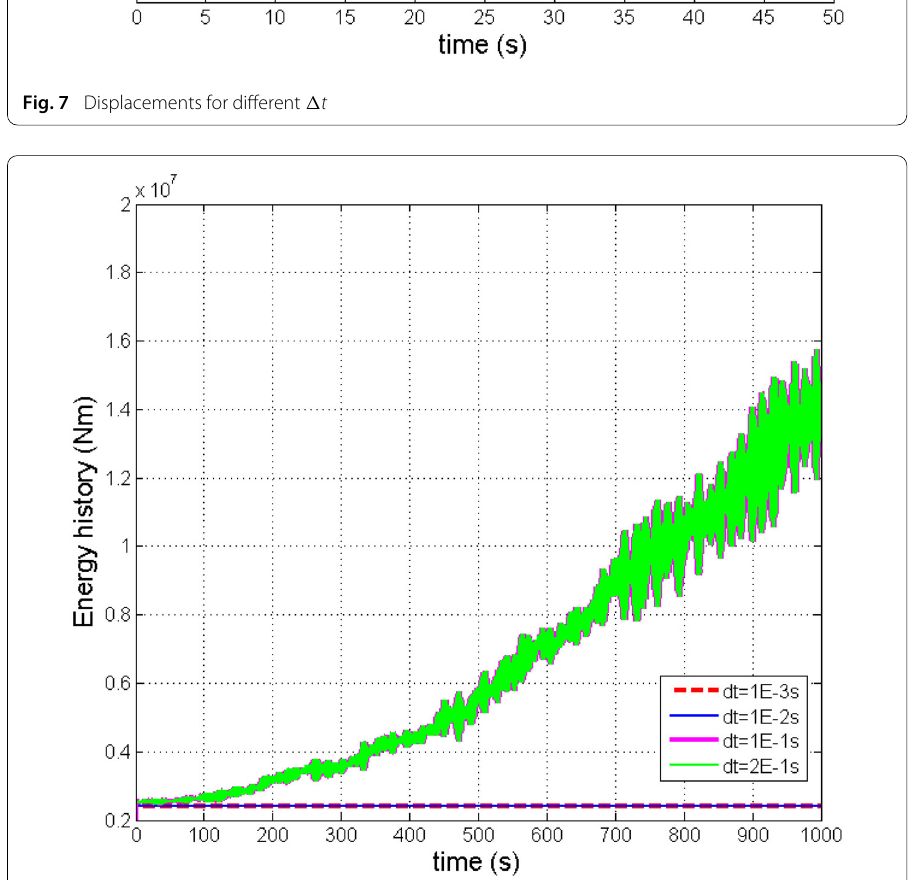
Fig. 8 Energy history for different